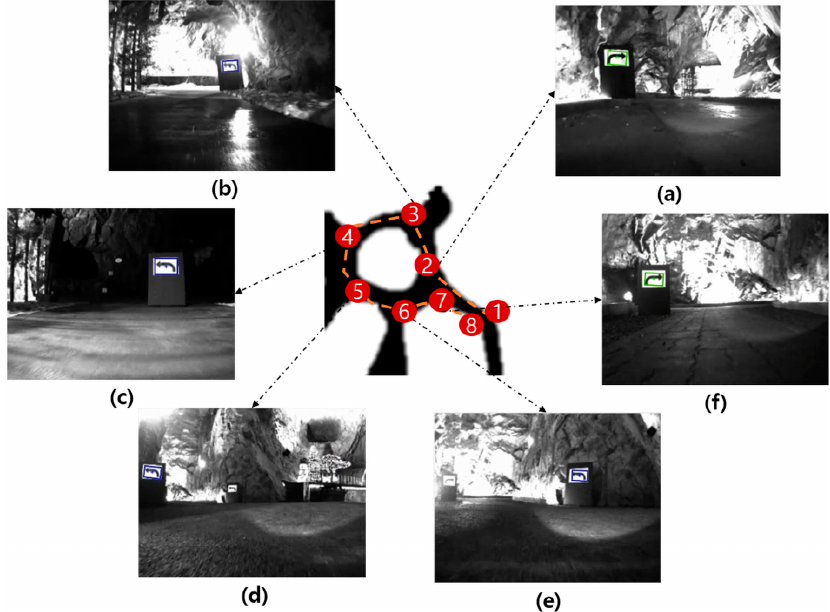
Figure 16. View of recognizing road signs in the experimental area using vision system developed in this study, ( a ) Site 2. ( b ) Site 3. ( c ) Site 4. ( d ) Site 5. ( e ) Site 6. ( f ) Site 7 (Reprinted from Ref. [108]).